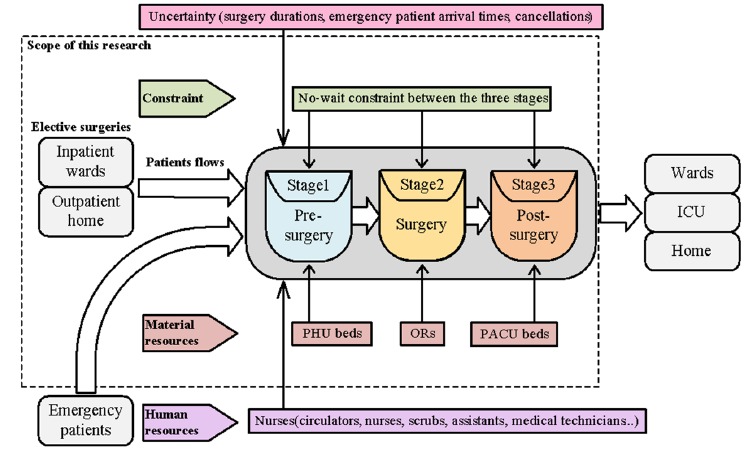
Figure 1. The scope of this